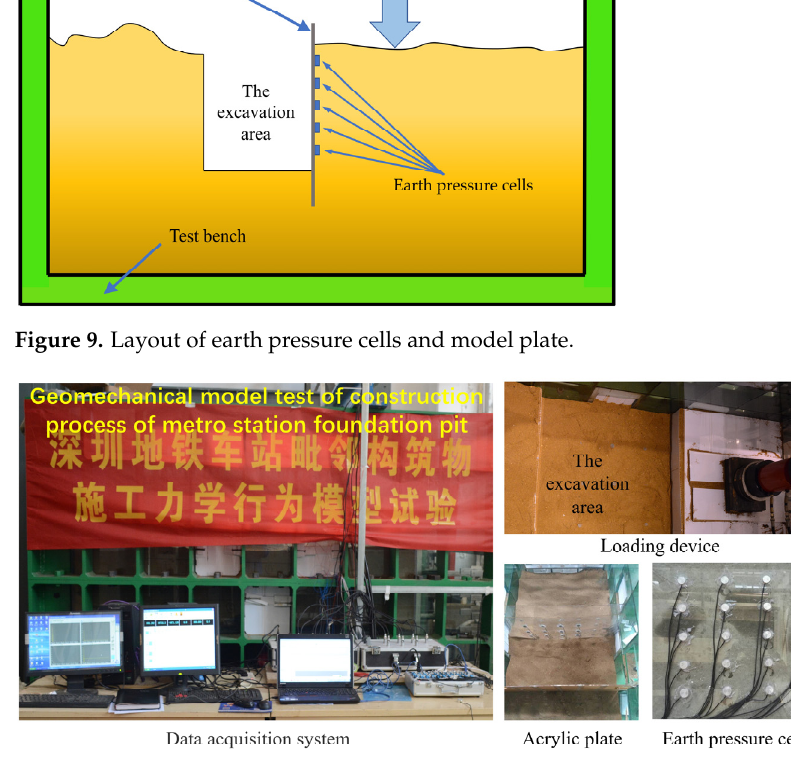
Figure 10. The model test of the metro station excavation.